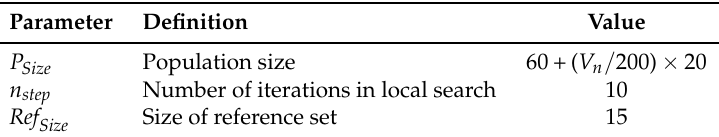
Table 2. Parameter